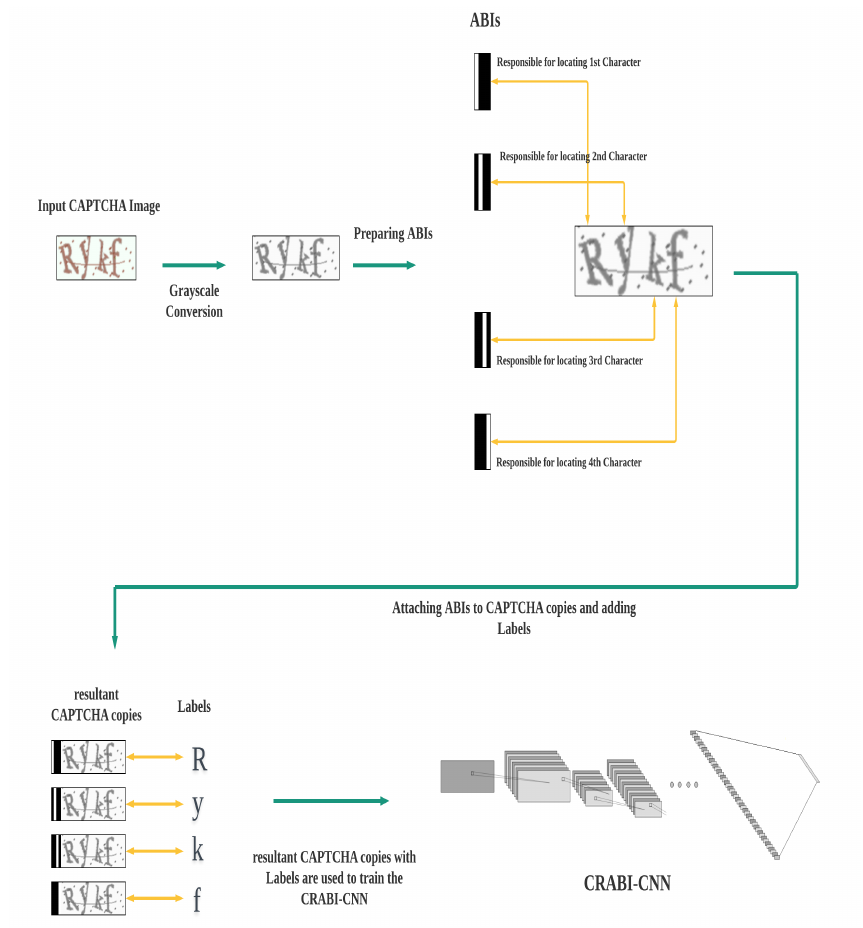
Figure 3. Framework description of the whole pipeline in training